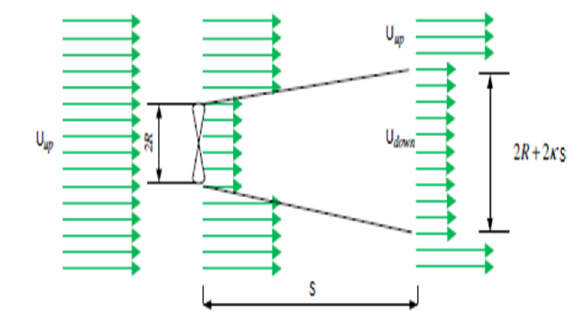
Fig. 1: Wind turbine wake model